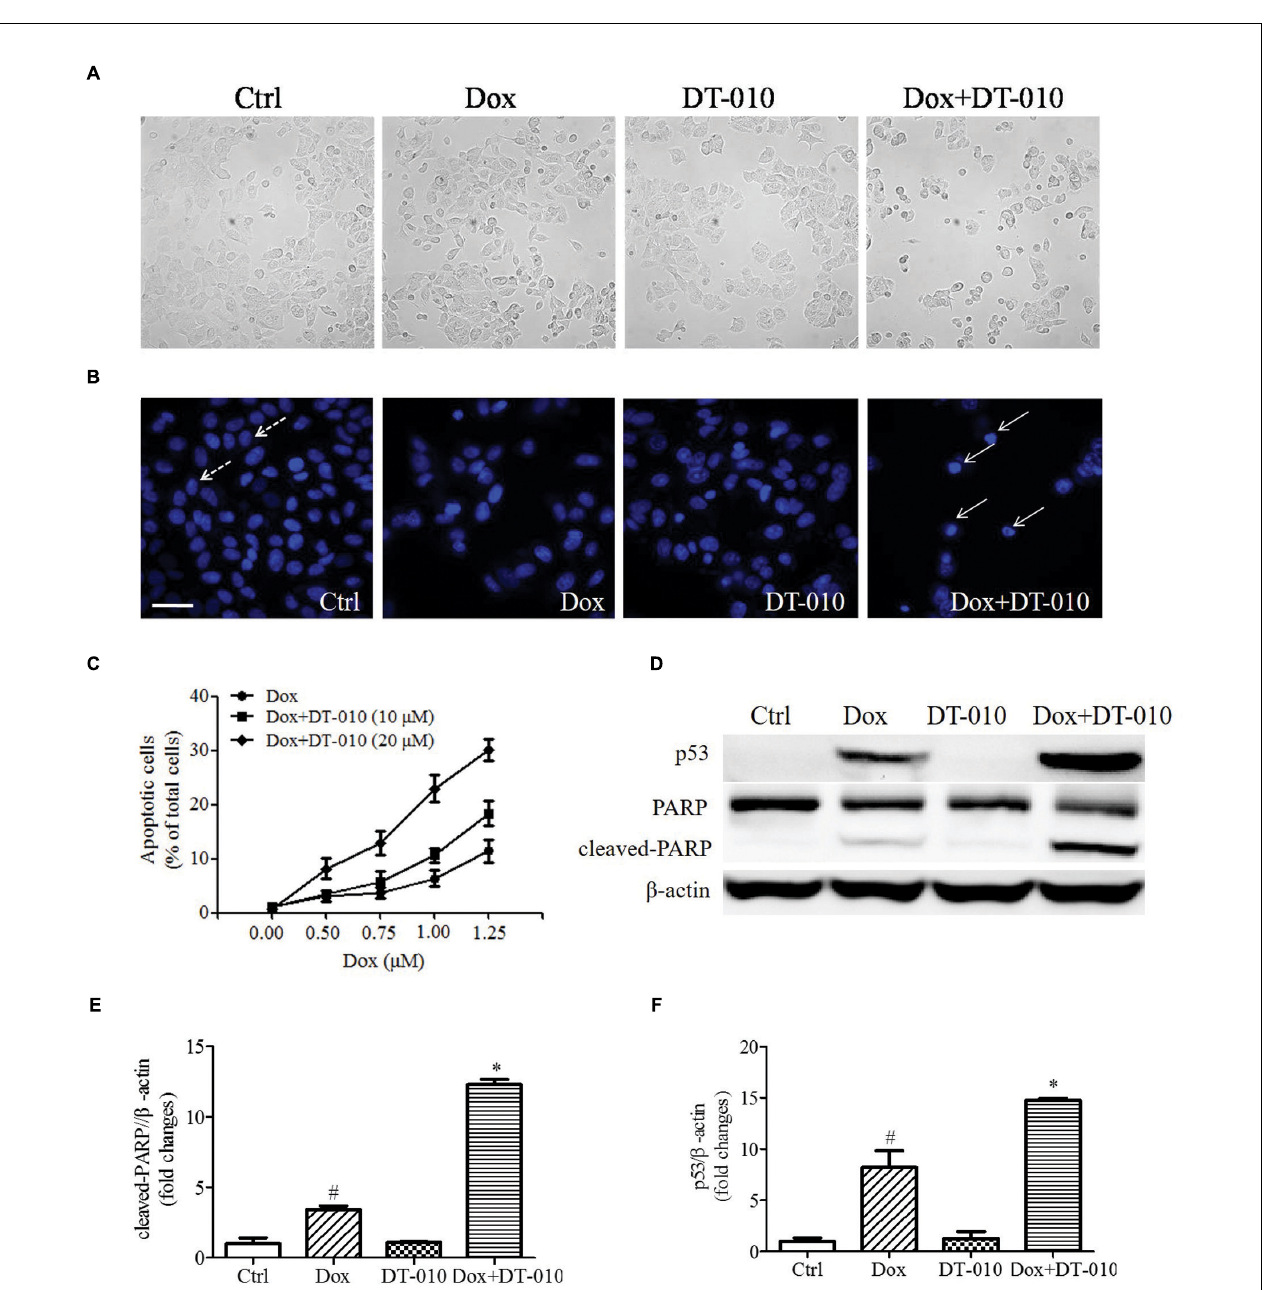
FIGURE 2 | DT-010 enhanced Dox induced apoptosis in MCF-7 cells. (A) Representative images of the cell morphology of MCF-7 cells. (B) Representative images of apoptotic cells in MCF-7 cells, which were stained with Hoechst33342. Dotted and solid arrows indicate the normal cells and apoptotic cells with chromatin condensation, respectively. Scale bar: 50 µ m. (C) The percentage of apoptotic cells in MCF-7 cells after 24 h of DT-010 and Dox treatment. (D) The expression of p53, PARP and cleaved-PARP proteins in MCF-7 cells were determined by Western blot after 24 h of Dox treatment in the presence or absence of DT-010. (E,F) Densitometric quantification of the expression of cleaved-PARP and p53 protein. # P < 0.05 vs. Ctrl and ∗ P < 0.05 vs.